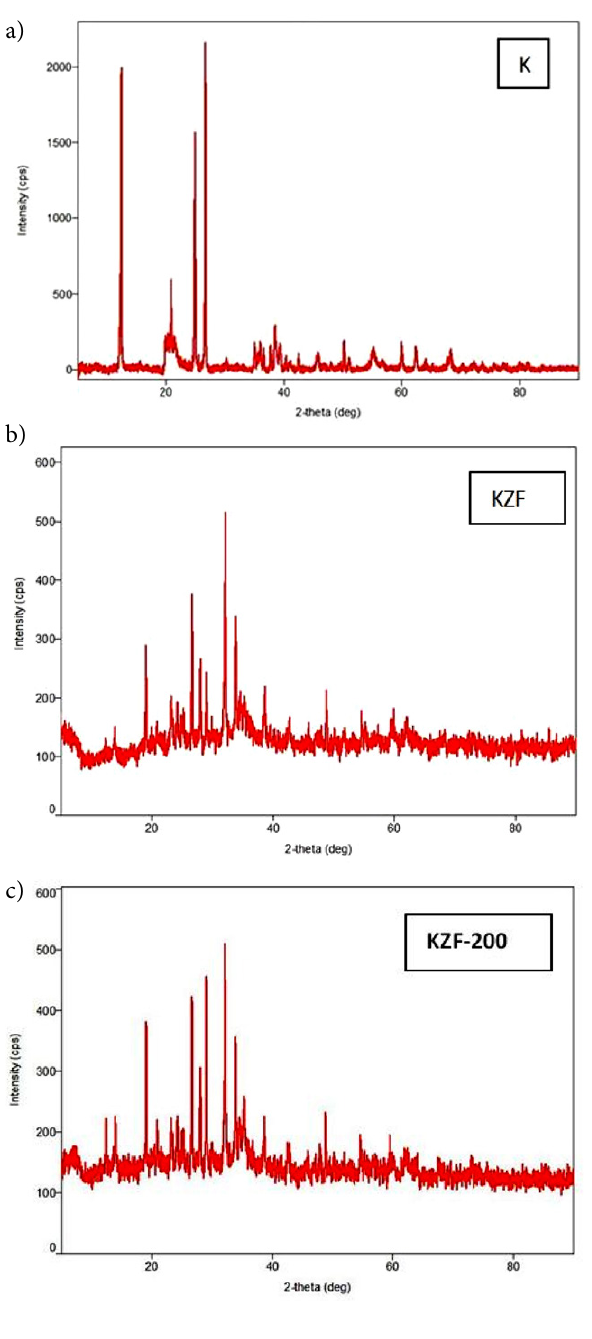
Fig. 3. XRD spectra of K, KZF and KZF-200